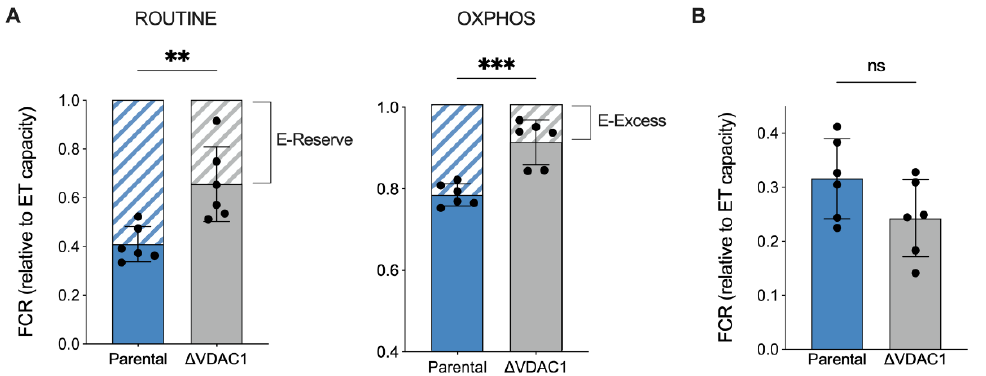
Figure 4. Analysis of flux control ratios (FCRs) in HAP1 cells. ( A ) The specific contribution of ROUTINE and OXPHOS states to ET capacity was calculated and demonstrated as FCRs, along with the respiratory reserves (dashed histograms), E-Reserve, and E-Excess. A significant increase in both FCR values was observed for Δ VDAC1 cells, which correspond to a proportional decrement of the reserves. ( B ) FCRs calculated for LEAK state. No significant differences were detected between parental and Δ VDAC1 cells. Data in ( A , B) are shown as mean ± SEM of n = 6 independent experiments and statistically analyzed by unpaired t -test, with ** p < 0.01 and *** p < 0.001; ns—not significant.